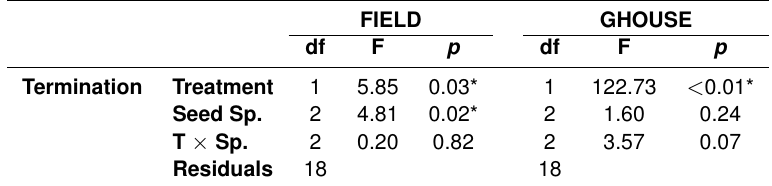
Figure A2. Daily precipitation (blue bars) and maximum air temperature (red line) during FIELD and GHOUSE experi- ments. Table A1. ANOVA tables for weed seed viability in FIELD and GHOUSE